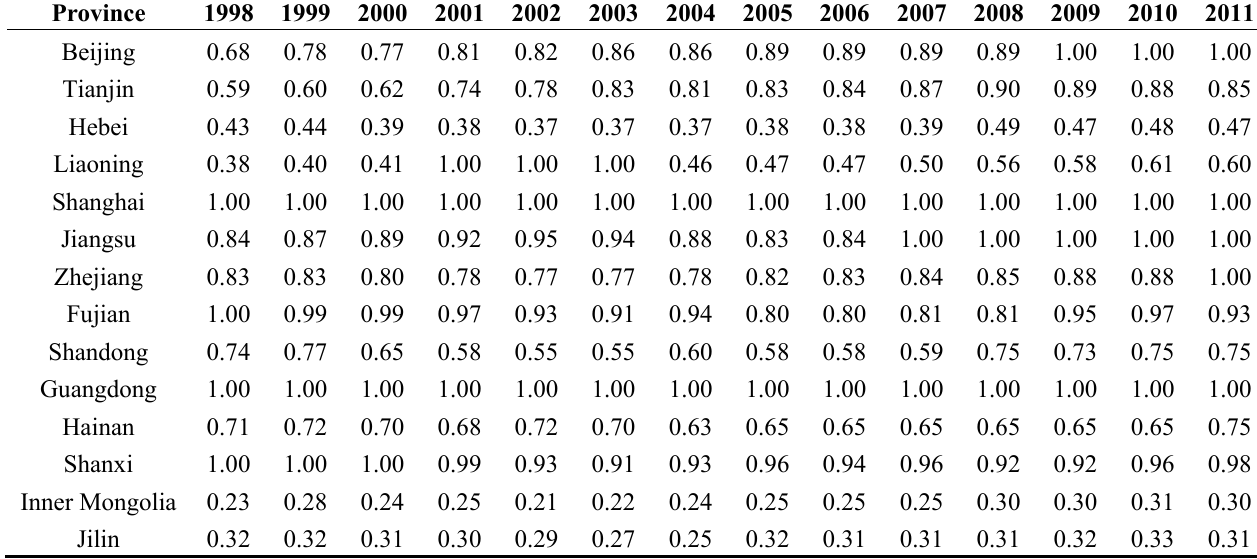
Table A. Energy Efficiency across China’s Thirty